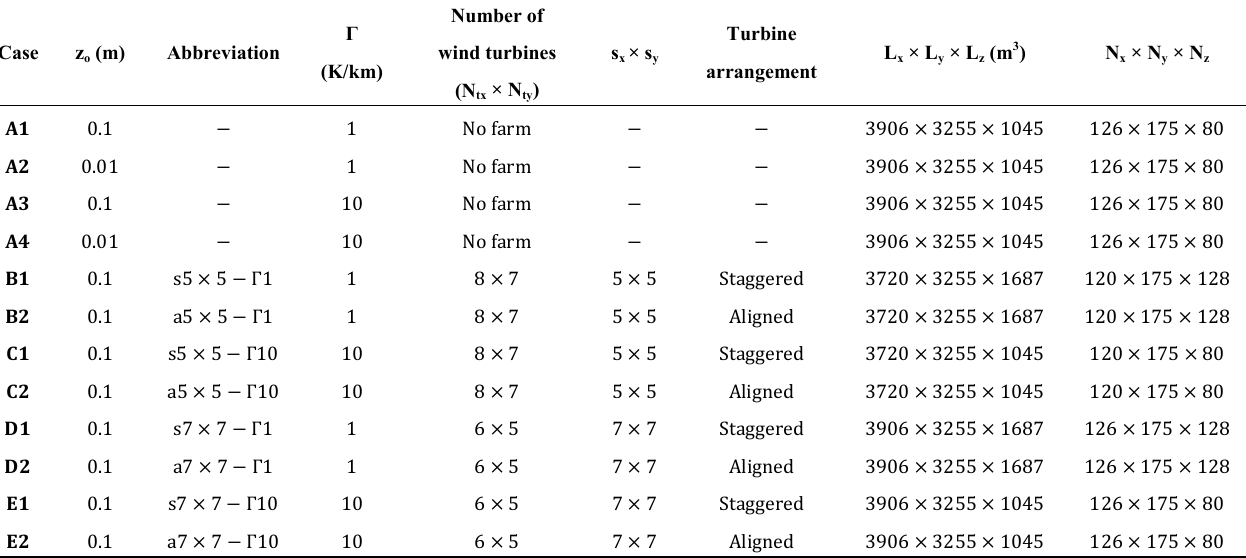
Table 1. Key parameters of the various LES